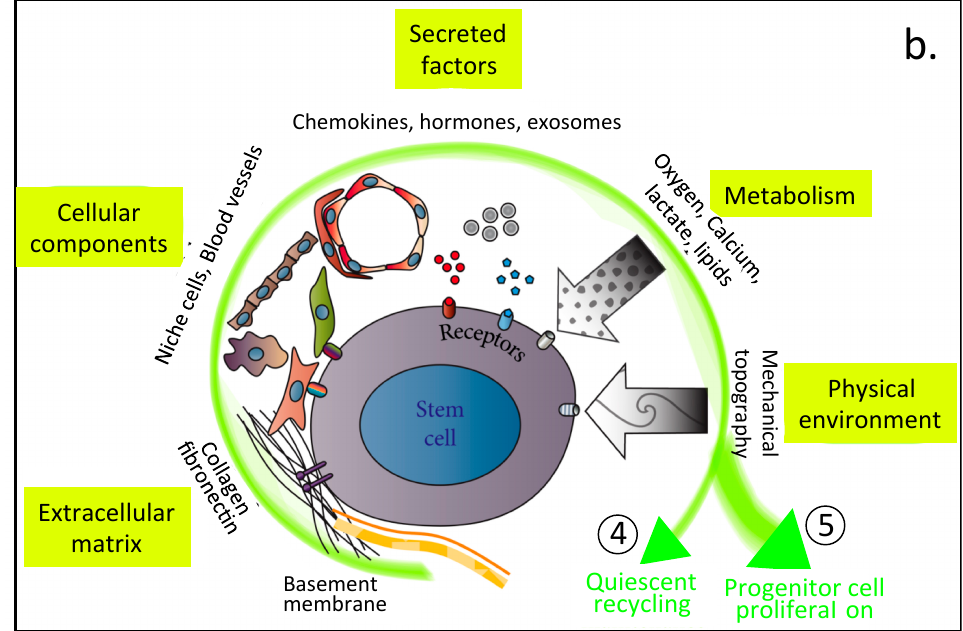
Figure 1. Schematic depiction of a cross-section through the human brain showing the two main regions of neuroprogenitor cells in the ventricular (1) and sub-granular regions of the dentate gyrus of the hippocampus (2) and the olfactory bulb (3), a storage region for neuroprogenitor cells ( a ). Segment ( b ) depicts schematically the multiple intrinsic and extrinsic influences exerted on stem cells in the niche micro-environment that determine whether stem cells undergo quiescent recycling (4) or attain a pluripotent migratory stem cell phenotype and escape from the regulatory niche (5) to participate in tissue development or tissue repair. Segment ( a ) reproduced from [15] with permission, © MA Healthcare Ltd 2008. Segment ( b ) reproduced from [16] with permission. Copyright ©